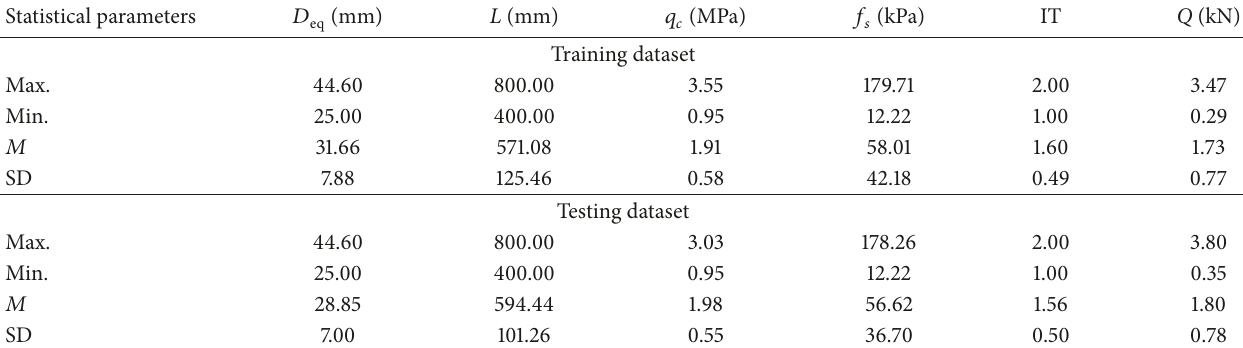
Table 1: Statistical measurements for the training and testing datasets. Statistical parameters